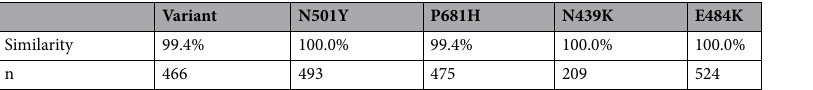
Table 9. Variant and mutation results from the RT-qPCR melting curve assays and the Sanger sequencing for the clinical validation cohort were compared how often they had similar results. Samples inconclusive for either the RT-qPCR assay or the Sanger sequencing are